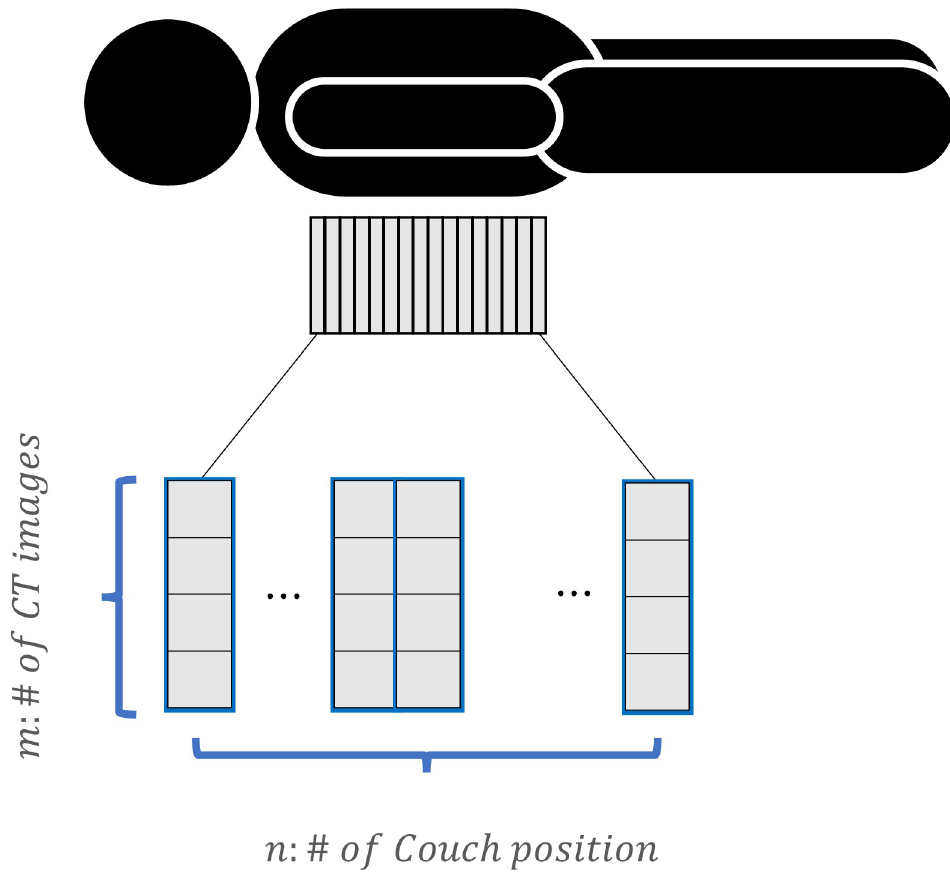
Fig 9. Schematic of 4DCT acquisition in cine